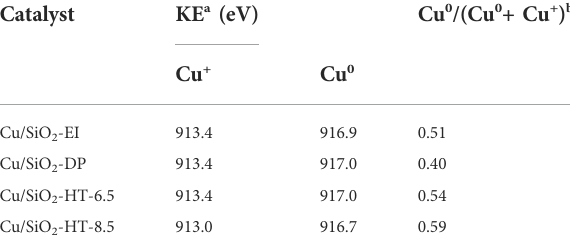
TABLE 2 Kinetic energy and ratio of Cu 0 /(Cu 0 + Cu + ) of Cu/SiO 2 catalysts prepared by different method.